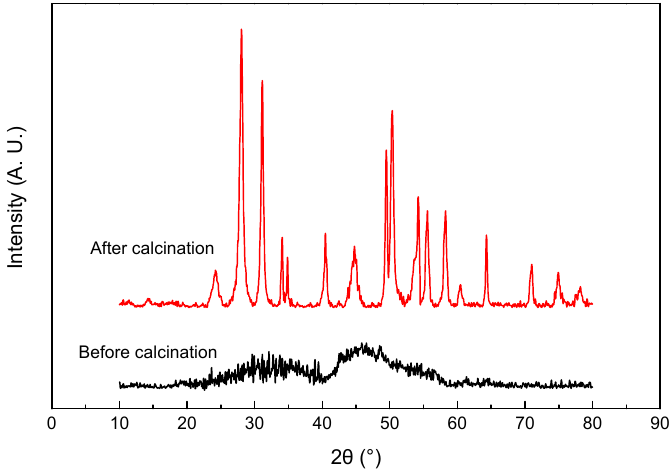
Figure 2. X-ray diffraction (XRD) patterns for deposited membrane before and after calcination.